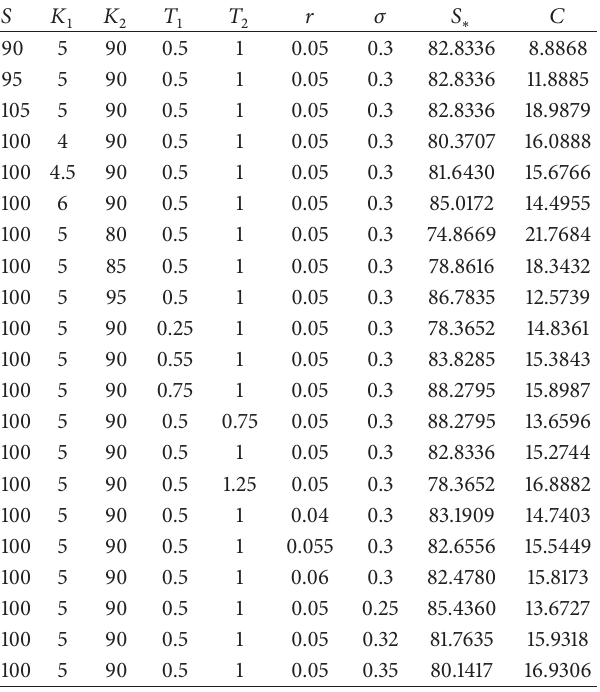
𝑀(̃𝐶) under the fuzzy